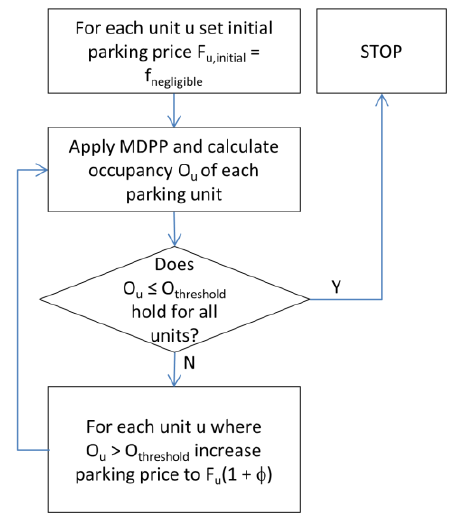
Figure 2. Flow chart of the Nearest Pocket for Prices Algorithm (NPPA) algorithm.